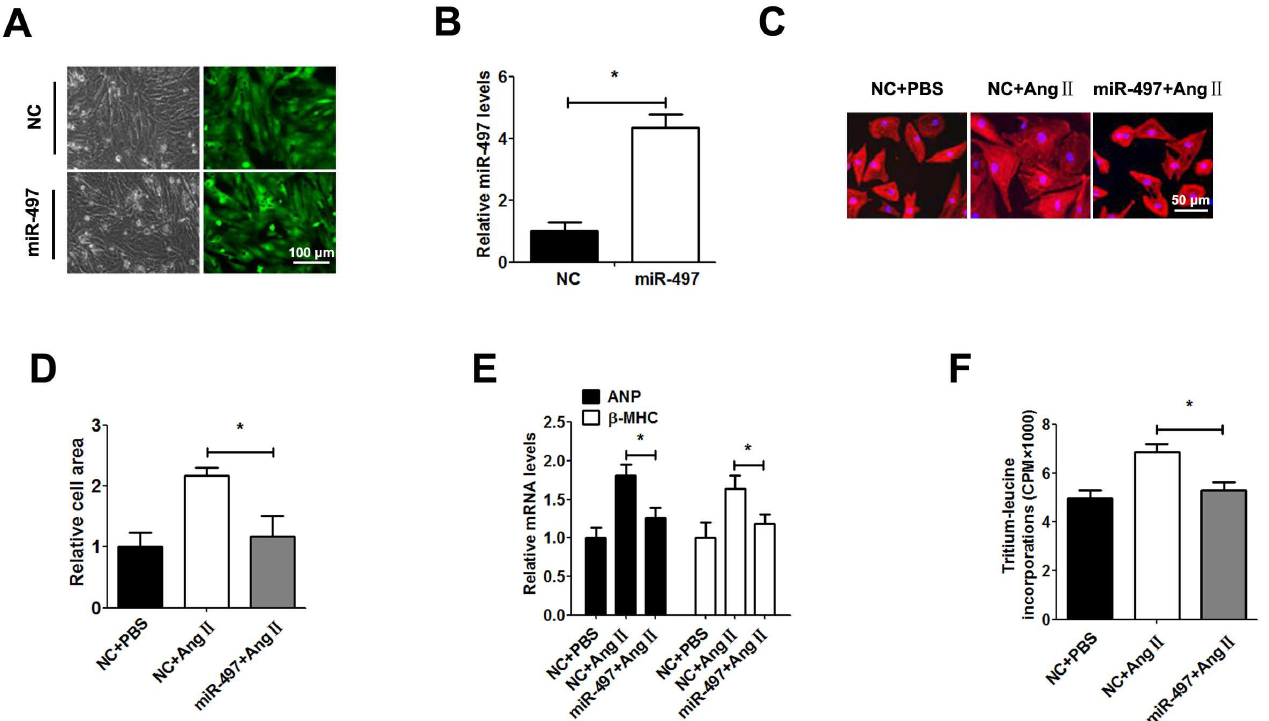
Fig 2. miR-497suppressescardiac hypertrophy in vitro. Ang II-induced hypertrophic cardiomyocyteswere infected with Leti-miR-497 or Leti-NC (MOI = 50) for 48 h. a: Representative image of GFP in cardiomyocytes under a fluorescence microscope. b: miR-497determinedby qRT-PCR. c: Representative immunofluorescenceimage of α -actin staining.d: Relativecell area in Ang II-induced hypertrophiccardiomyocytes after infection. e: ANP and β -MHC mRNA expressions measuredby qRT-PCR. f: Tritium-leucineincorporations detected by liquidscintillation counting.Data are presented as the mean ± SD; * , P < 0.05, n =